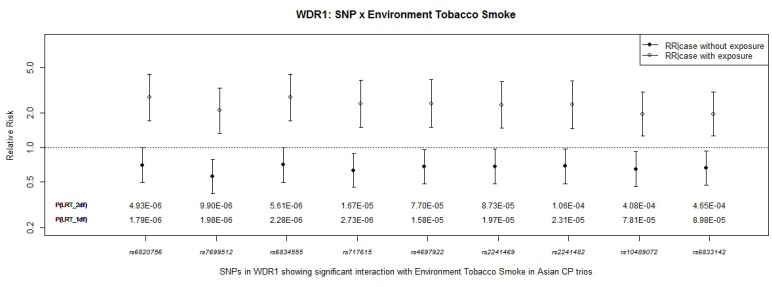
WDR1: SNP × Environmental Tobacco Smoke.Estimated RR(CP|G no E) and RR(CP|G and E) from conditional logistic regression model considering SNP effects and their interaction with maternal exposure to ETS on 259 CP case-parent trios of Asian ancestry for nine SNPs in WDR1. P-values from the 2 df and 1 df LRT for GxE interaction are shown along the X axis.